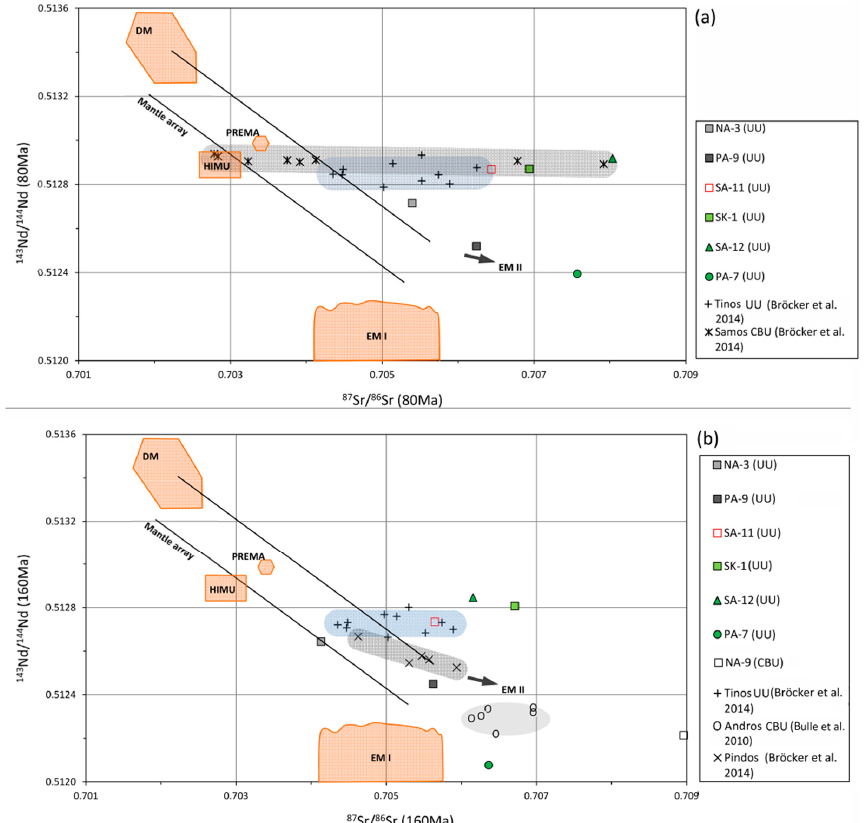
Figure 10. Sr–Nd isotope compositions of mafic rocks from the Upper Units of Naxos, Paros, Samos (Kallithea), and Skyros and Naxos amphibolites, also showing data from the HP-mélange blocks from central Samos, Tinos, and a Pindos-Avdella melange [15,28]. ( a ) 87 Sr/ 86 Sr vs. 143 Nd/ 144 Nd plot for age recalculation t = 80 Ma; schematic fields of comparison indicated by abbreviations: N-MORB = Normal type Mid-Ocean Ridge Basalt; OIB = Ocean-Island basalt; IAB = Island Arc Basalt; ( b ) 87 Sr/ 86 Sr vs. 143 Nd/ 144 Nd plot with ratios calculated for t = 160 Ma. Terrestrial mantle reservoirs: DMM, HIMU, PREMA, EM-I, EM-II from [69].